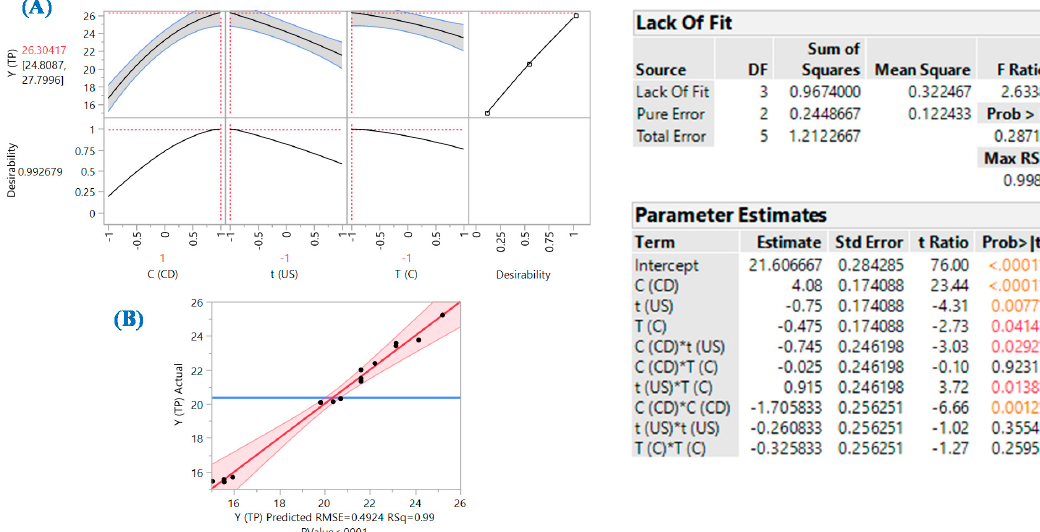
Figure 1. Analytical information associated with model fitting and assessment, constructed by implementing response surface methodology. ( A , B ) correspond to the desirability function and actual-to-predicted plot. Asterisk (*) in the inset table “Parameter Estimates” indicates statistically significant terms, at least at a 95% significance level.